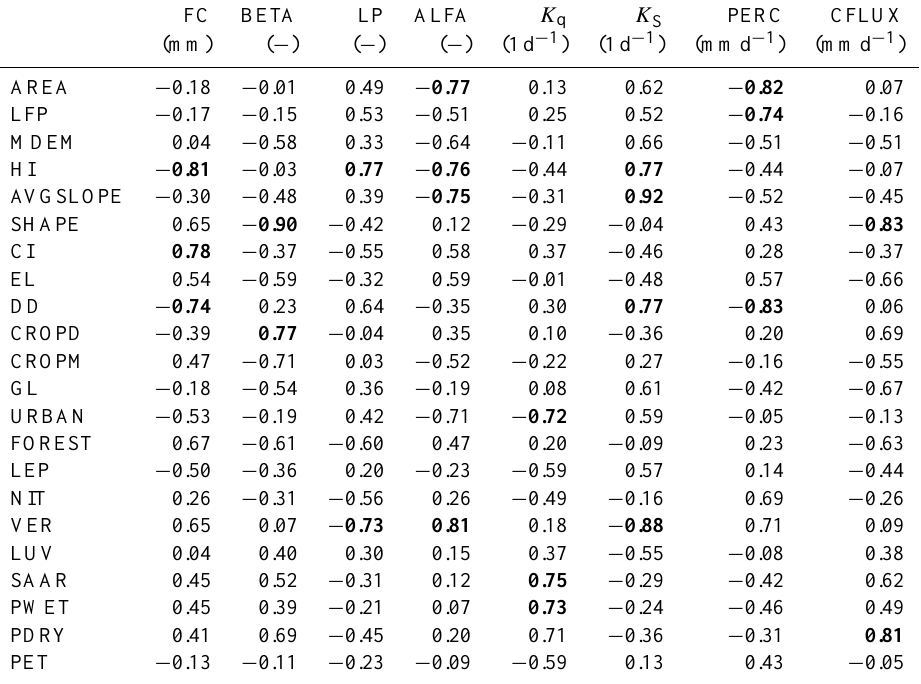
Table 4. Correlation matrix between model parameters and PCCs for 6 selected catchments; significant correlation coefficients are in